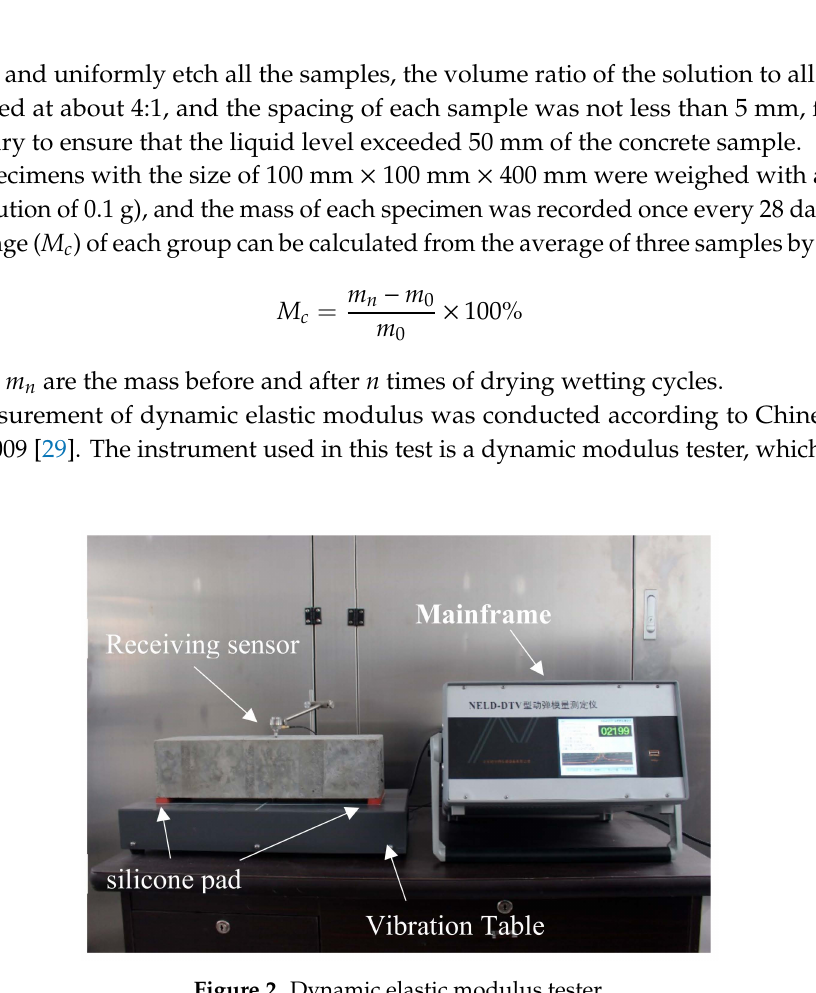
Figure 2. Dynamic elastic modulus